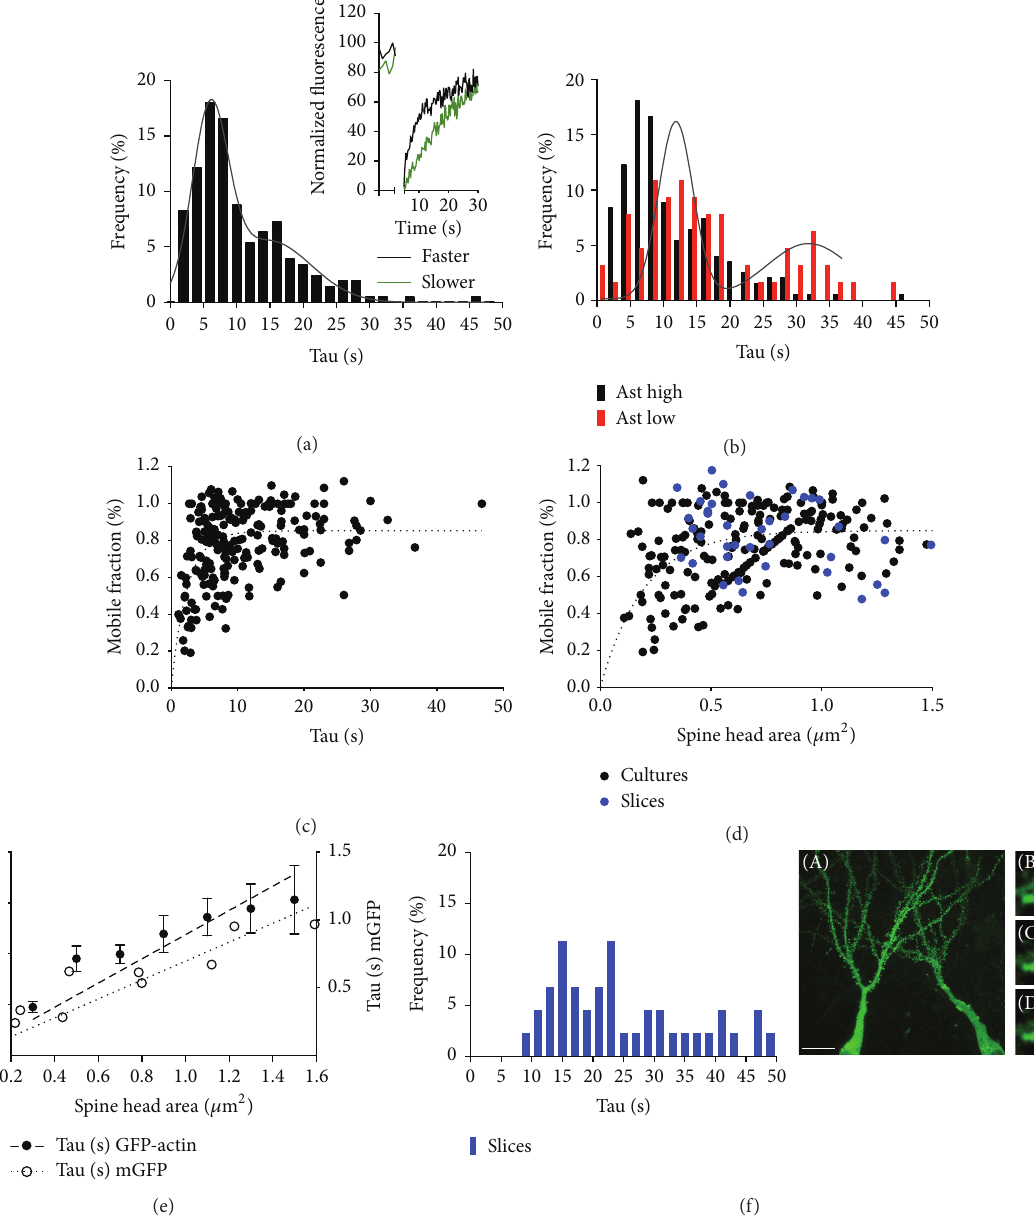
Figure 3: Spines can be divided into two categories, according to their fluorescence recovery time. (a) Frequency distribution of tau values in “Ast high” condition (black bars) ( 𝑛 = 205 spines). Distribution was adjusted to a two-Gaussian distribution, with two peak values of 6.02±2.70 and 14.87±6.32 seconds ( 𝐹 test, 𝑝 < 0.0001 ) (gray line). Insert depicts two representative recovery curves for each category. Only the initial 30 seconds are displayed. Curves were normalized and scaled to the same initial time. (b) Frequency distribution of tau values in the “Ast low” condition (red bars) ( 𝑛 = 72 spines). Distribution was adjusted to a two-Gaussian distribution, with two estimates peak values of 15.12 ± 2.3 and 35.42 ± 4.22 seconds ( 𝐹 test, 𝑝 < 0.0001 ) (gray line). Black bars show the frequency distribution of tau values in “Ast high” condition, plotted for comparison. (c) The mobile fraction of each “Ast high” spine was plotted against its recovery time value (dotted line, one phase exponential association). Note that spines with higher mobile fractions present slow recovery times, and vice versa. (d) Mobile fraction values of “Ast high” spines were plotted against their spine head area (black dots) ( 𝑛 = 210 spines). Of interest, spines with a larger head area show higher mobile fractions, and vice versa. Blue dots represent spines from hippocampal culture slices ( 𝑛 = 44 spines). Spines from hippocampalslicesshowhighmobilefractionsandlargerspineheadareas.(e)Leftaxis:spineheadareasweregrouped(0.2 𝜇 m 2 intervals)and their mean average areas were plotted against their average recovery time ( 𝑛 = 198 spines, mean ± SEM). The value distribution was adjusted to a linear regression (slope: 11.89 ± 0.80 ). Right axis: same relation employing spines transfected with monomeric GFP (slope: 0.69 ± 0.054 ) ( 𝑛 = 9 spines). Both graphs show a lineal relation between bleach area and fluorescence recovery constant, although with a tenfold difference in scale. (f) Right picture. (A) Example of two pyramidal hippocampal neurons expressing GFP-actin from an organotypic slice culture. Scale bar: 20 𝜇 m. (B to D) Sequential frames of a FRAP experiment. Scale bar: 2 𝜇 m. Average mobile fraction was estimated to be 0.84±0.02 ( 𝑛 = 49 spines). Left graph: frequency distribution of tau values obtained from hippocampal slices ( 𝑛 = 42 spines, blue bars). Notice how slice spines fall mostly into a single distribution. Spine MF values from cultures and slices were not statistically different (Mann-Whitney test,